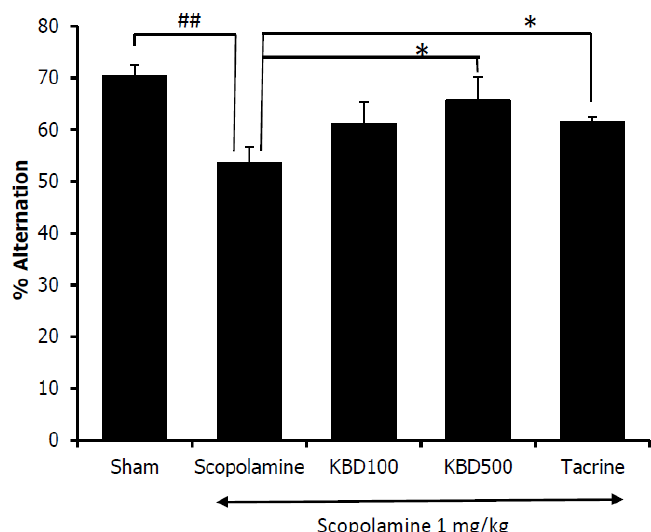
Figure 7. E ff ect of the KBD (100 and 500 mg / kg) on memory impairment induced by scopolamine in Y-maze test. Tacrine at the dose of 10 mg / kg / day was used as a reference standard. The data were shown as mean ± SEM ( n = 8–10). ## p < 0.01 versus control group (Sham), * p < 0.05 versus scopolamine-treated